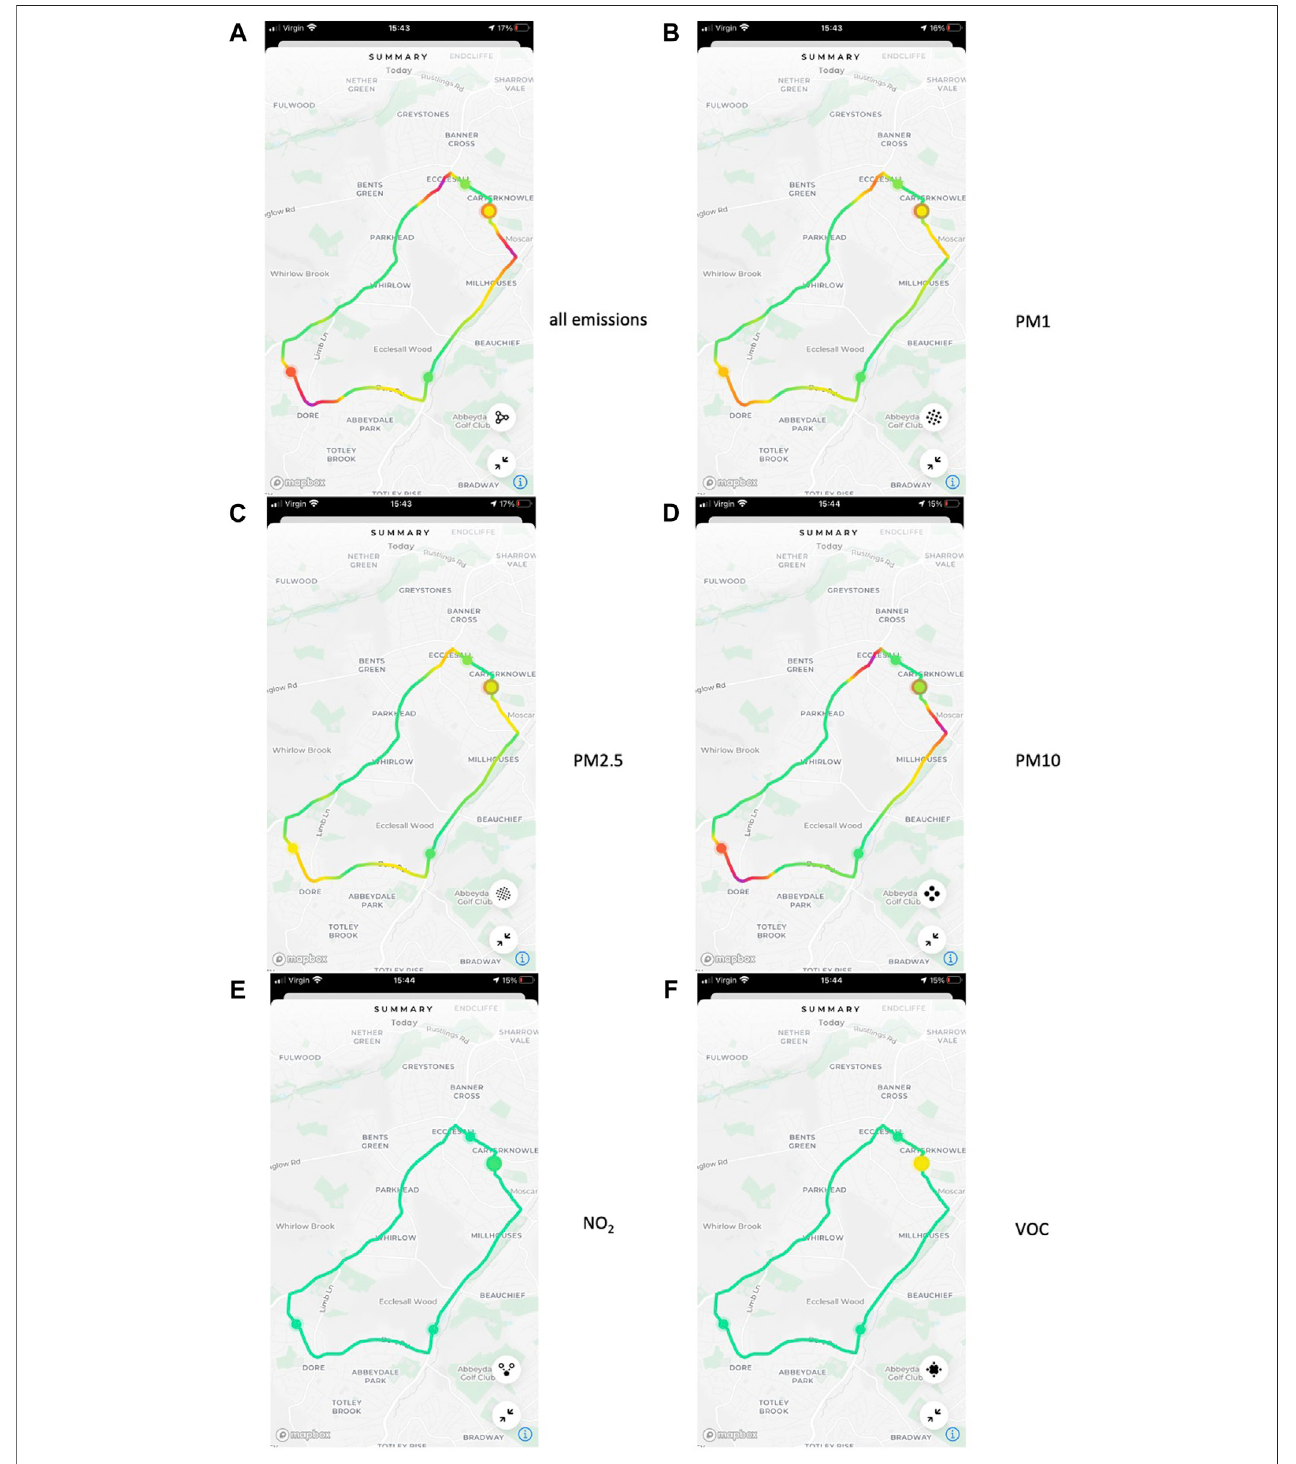
FIGURE 2 | Emission data during United Kingdom Lockdown 3. Wind was blowing at 9 mph from the southwest. Light traf fi c and no obvious wood fi res, except wood-burning stoves in Dore (Flow 2 data). The circular pictograms refer to the species analysis as given in the chemical labels at the side of each fi gure.